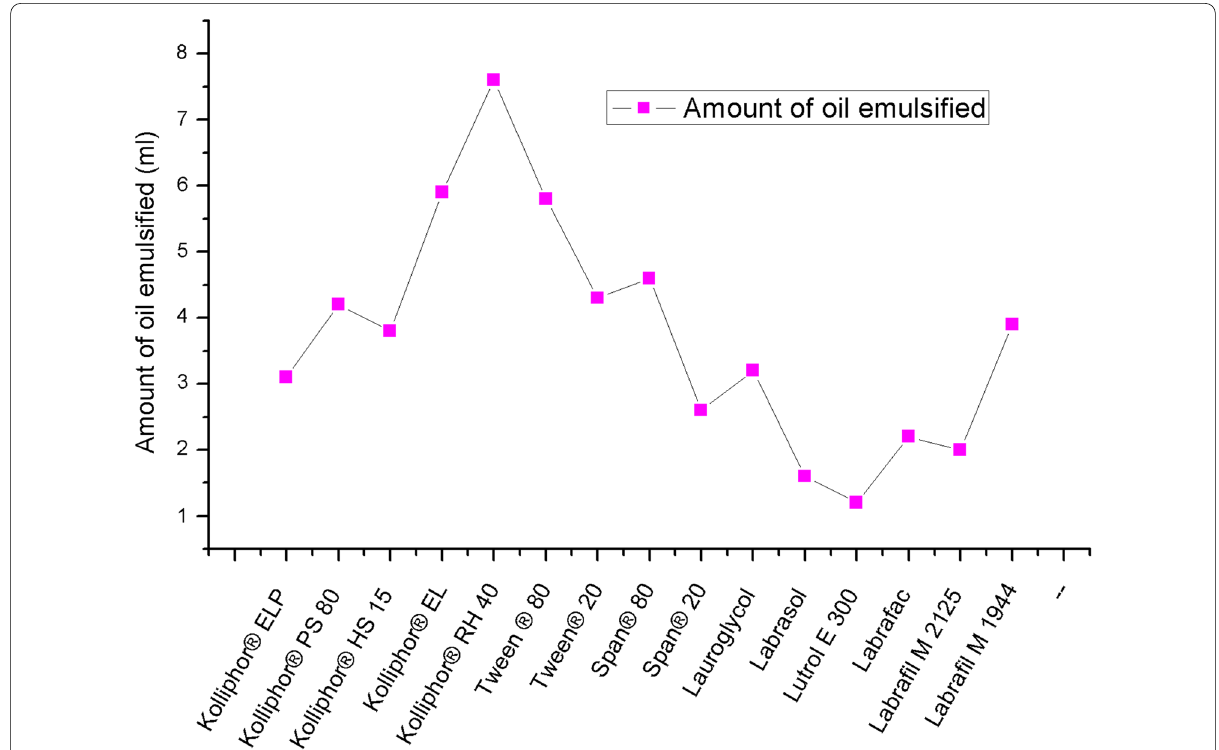
Fig. 2 Amount of oil emulsified by different